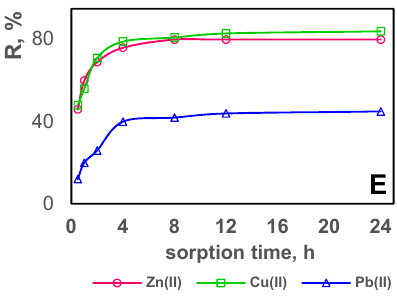
Figure 10. The reduction in Zn(II), Cu(II) and Pb(II) ion concentration expressed as a percentage of